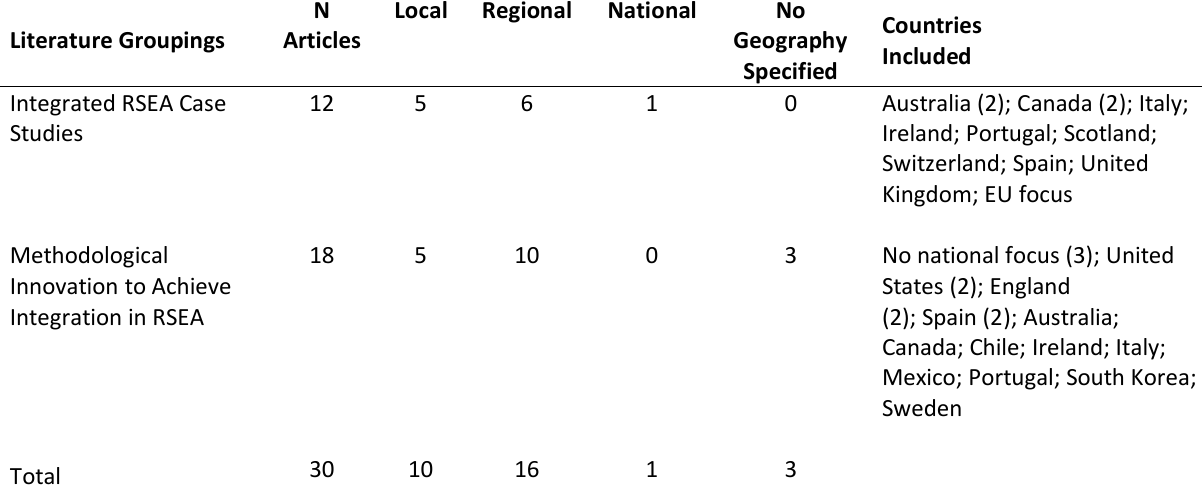
Table 1. Geographic distribution of peer-reviewed articles on integrated regional and/or strategic environmental